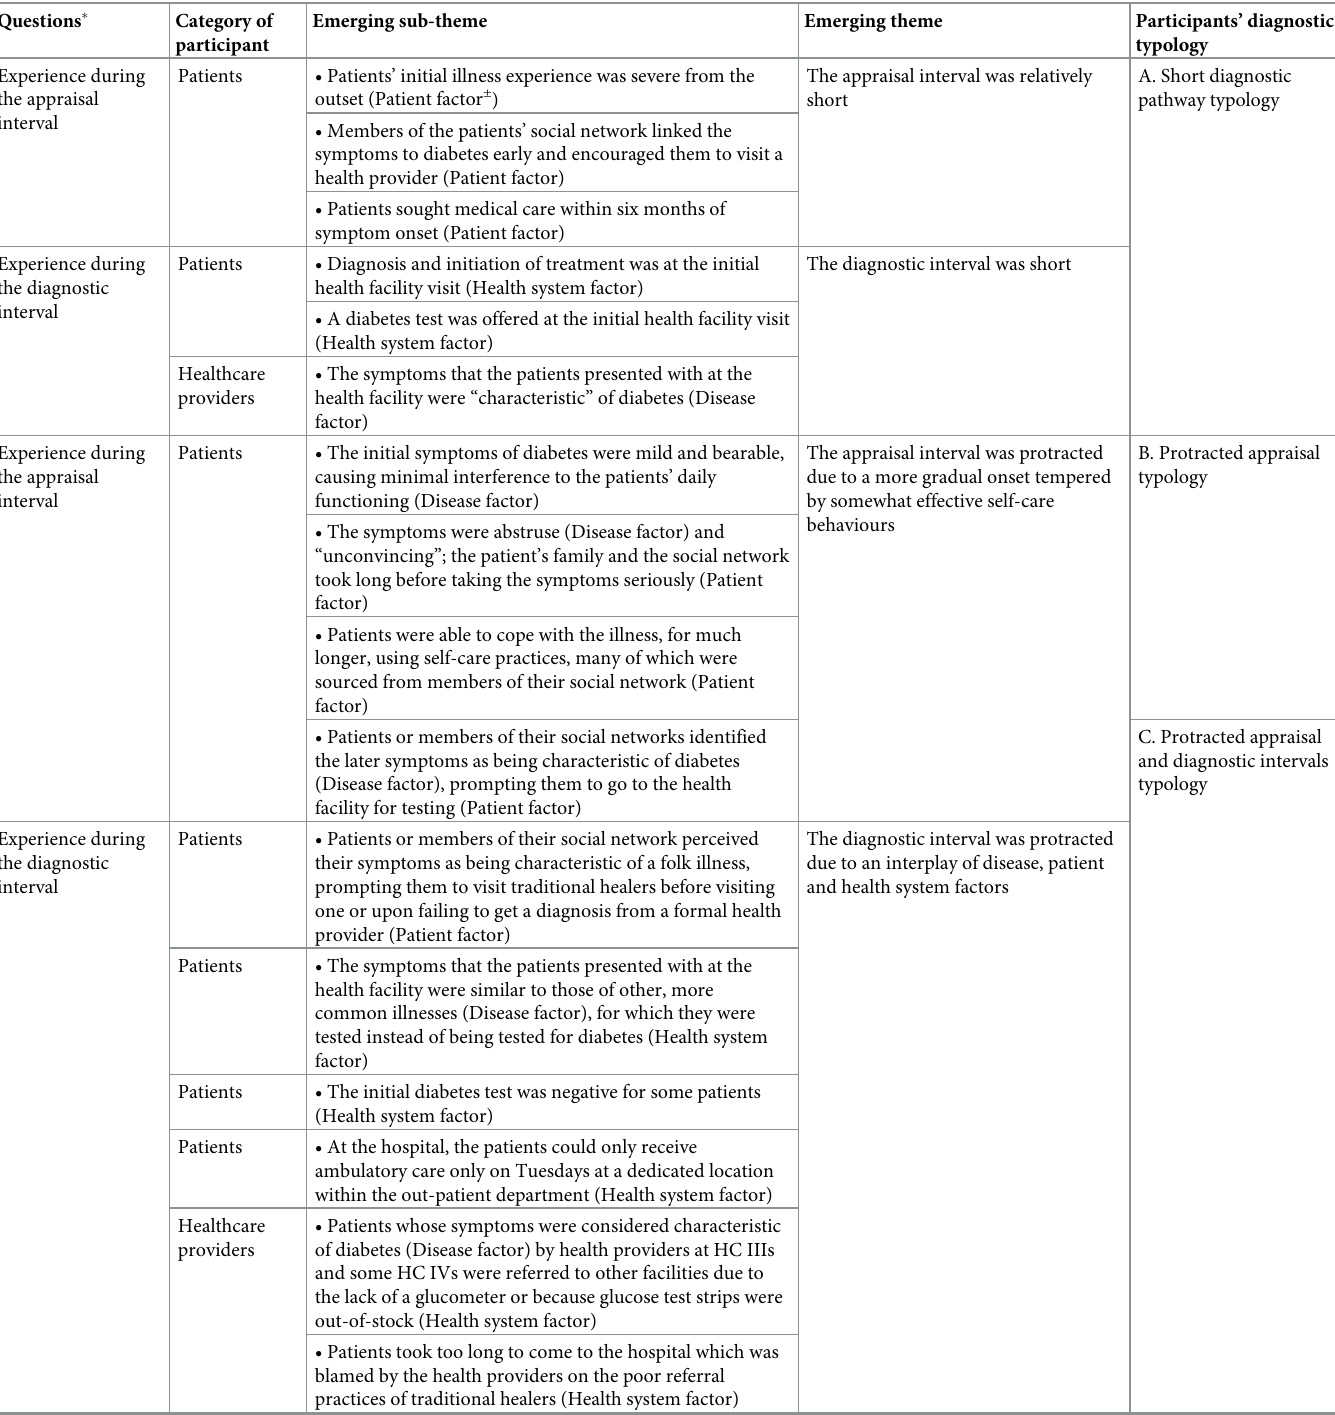
Table 3. Summary of emerging sub-themes and